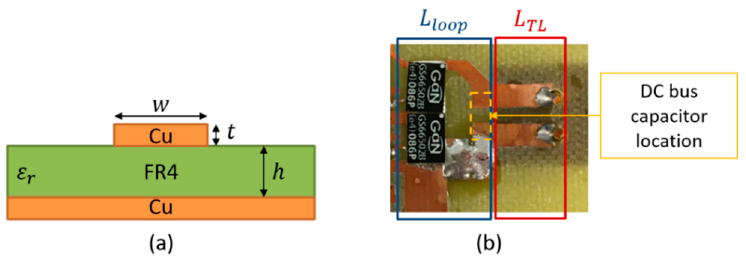
Figure 2. Characterization fixture ( a ) microstrip transmission line parameters (bottom layer as ground plane); ( b ) lateral commutation loop connected to transmission lines.